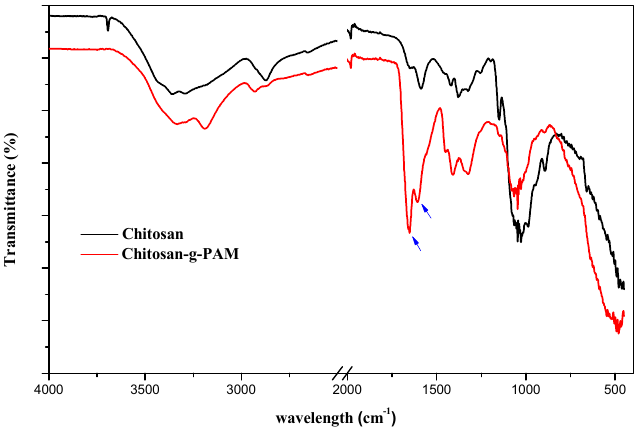
Figure 3. ATR-FTIR spectra of chitosan and chitosan-g-polyacrylamide (CS-g-PAM).